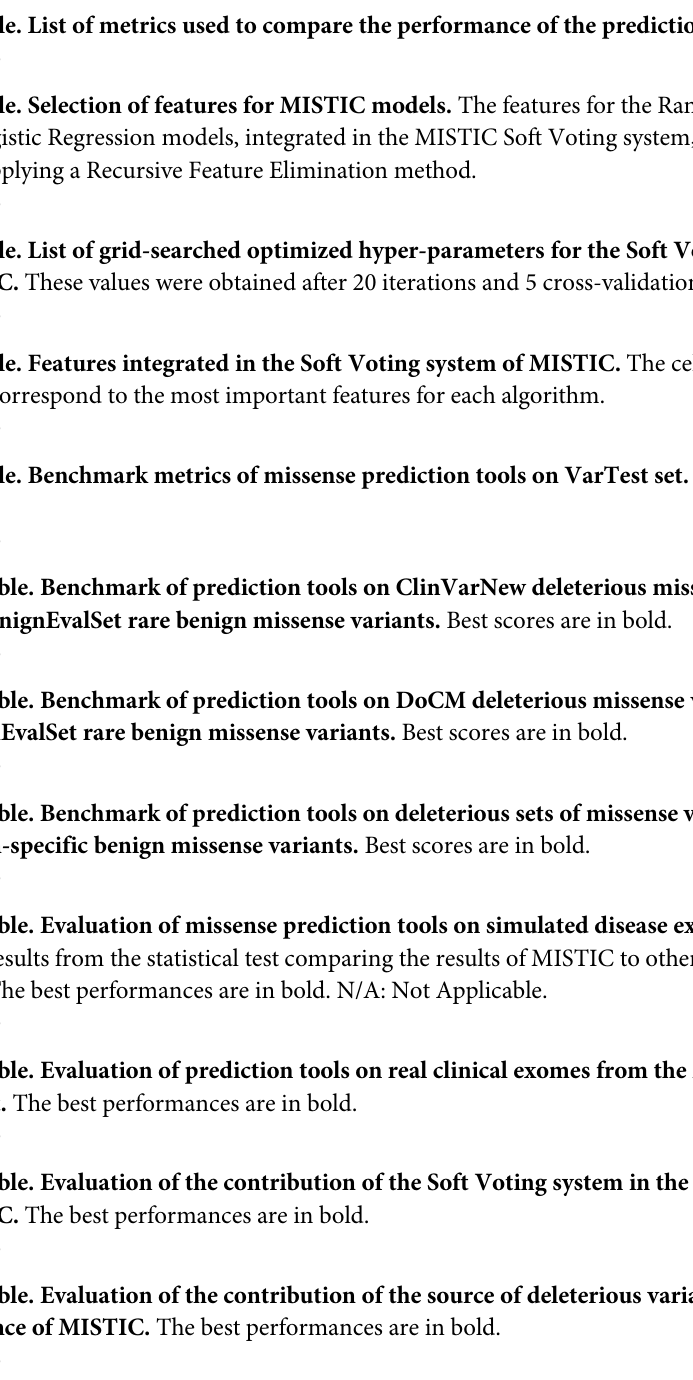
S4 Table. List of recommended thresholds used for the prediction tools. � —There was no recommended threshold for Eigen. Hence, by default the threshold of Eigen was set to 0. N/A: Not Applicable. S5 Table. List of metrics used to compare the performance of the prediction tools. (XLSX) S6 Table. Selection of features for MISTIC models. The features for the Random Forest and the Logistic Regression models, integrated in the MISTIC Soft Voting system, were selected after applying a Recursive Feature Elimination method. S7 Table. List of grid-searched optimized hyper-parameters for the Soft Voting systems of MISTIC. These values were obtained after 20 iterations and 5 cross-validations. S8 Table. Features integrated in the Soft Voting system of MISTIC. The cells highlighted in green correspond to the most important features for each algorithm. S9 Table. Benchmark metrics of missense prediction tools on VarTest set. Best scores are in bold. S10 Table. Benchmark of prediction tools on ClinVarNew deleterious missense variants and BenignEvalSet rare benign missense variants. Best scores are in bold. S11 Table. Benchmark of prediction tools on DoCM deleterious missense variants and BenignEvalSet rare benign missense variants. Best scores are in bold. S12 Table. Benchmark of prediction tools on deleterious sets of missense variants and pop- ulation-specific benign missense variants. Best scores are in bold. S13 Table. Evaluation of missense prediction tools on simulated disease exomes. The p- value results from the statistical test comparing the results of MISTIC to other prediction tools. The best performances are in bold. N/A: Not Applicable. S14 Table. Evaluation of prediction tools on real clinical exomes from the MyoCapture project. The best performances are in bold. S15 Table. Evaluation of the contribution of the Soft Voting system in the performance of MISTIC. The best performances are in bold. S16 Table. Evaluation of the contribution of the source of deleterious variants in the per- formance of MISTIC. The best performances are in